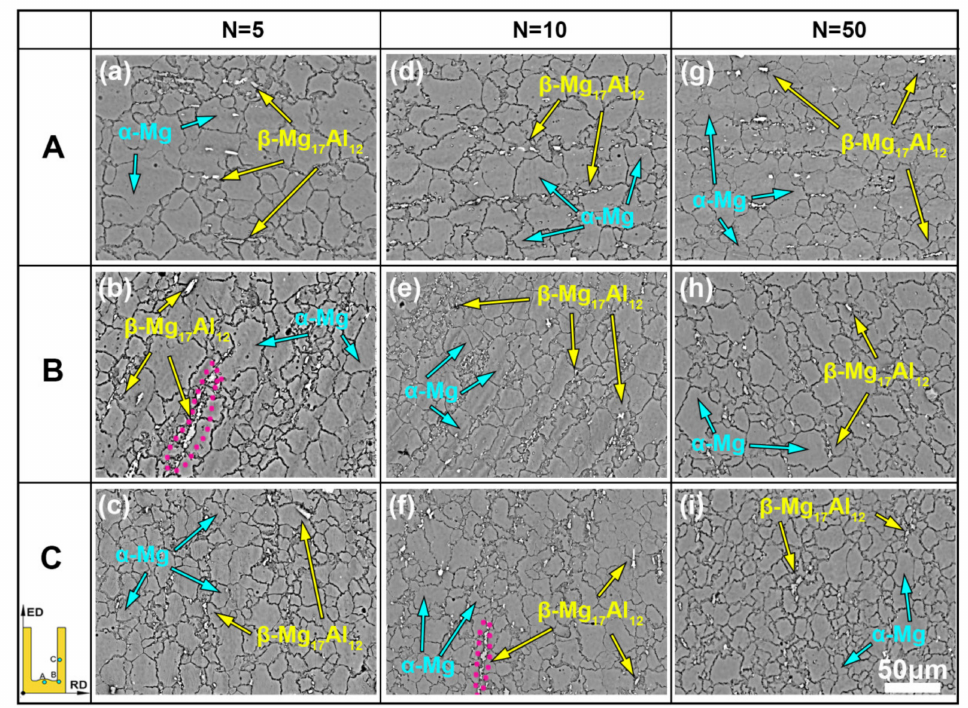
Figure 4. The BSE images of the RBE samples at the three di ff erent locations: ( a – c ) n = 5, ( d – f ) n = 10, and ( g – i ) n =